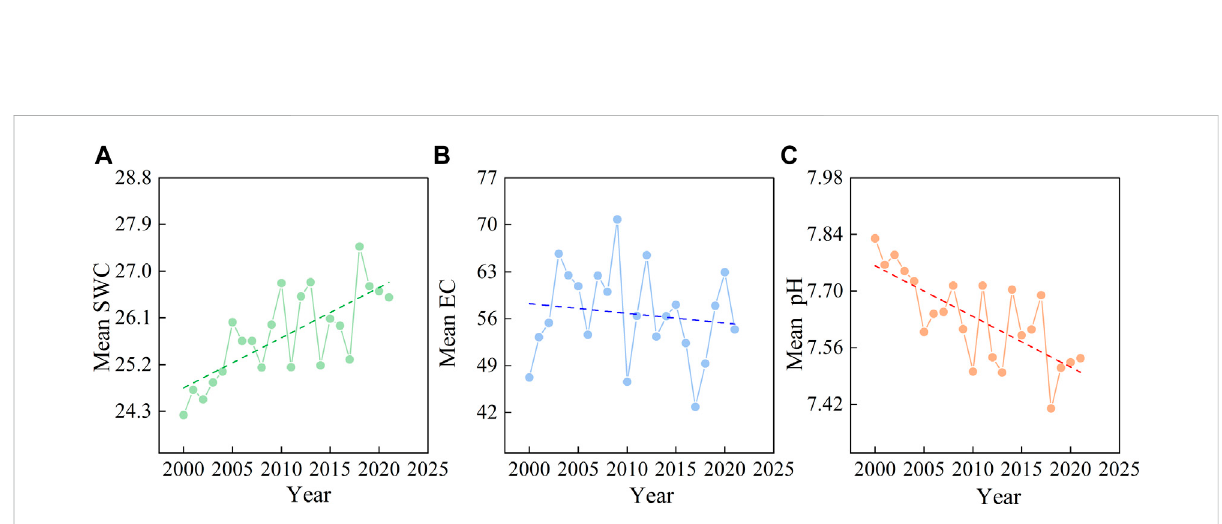
Frontiers in Environmental